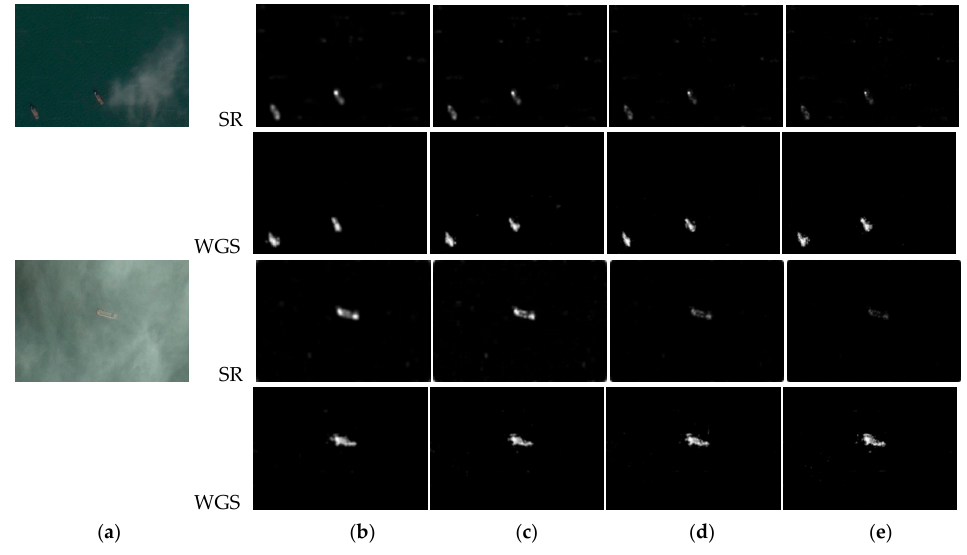
Figure 15. The detection results for multi-size images. ( a ) Input image; ( b ) 300 × 210; ( c ) 406 × 283; ( d ) 505 × 354; and ( e ) 612 × 428. ( d ) 505 × 354; and ( e ) 612 ×